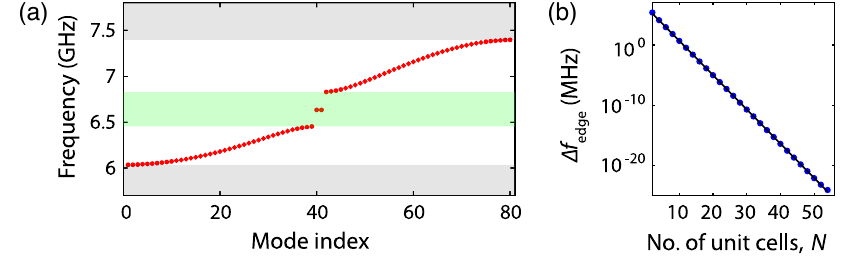
FIG. 7. (a) Resonant frequencies of a finite system with N ¼ 40 unit cells, calculated from eigenmodes of Eq. (B3). The band gap regions calculated from dispersion relation are shaded in gray (green) for upper and lower band gaps (middle band gap). The two data points inside the middle band gap (mode indices 40 and 41) correspond to edge modes. (b) Frequency splitting Δ f with no disorder in the system are plotted against the of number of unit cells N . The black solid curve indicates exponential fit to the edge mode splitting, with decay constant of ξ ¼ 1 . 76 .